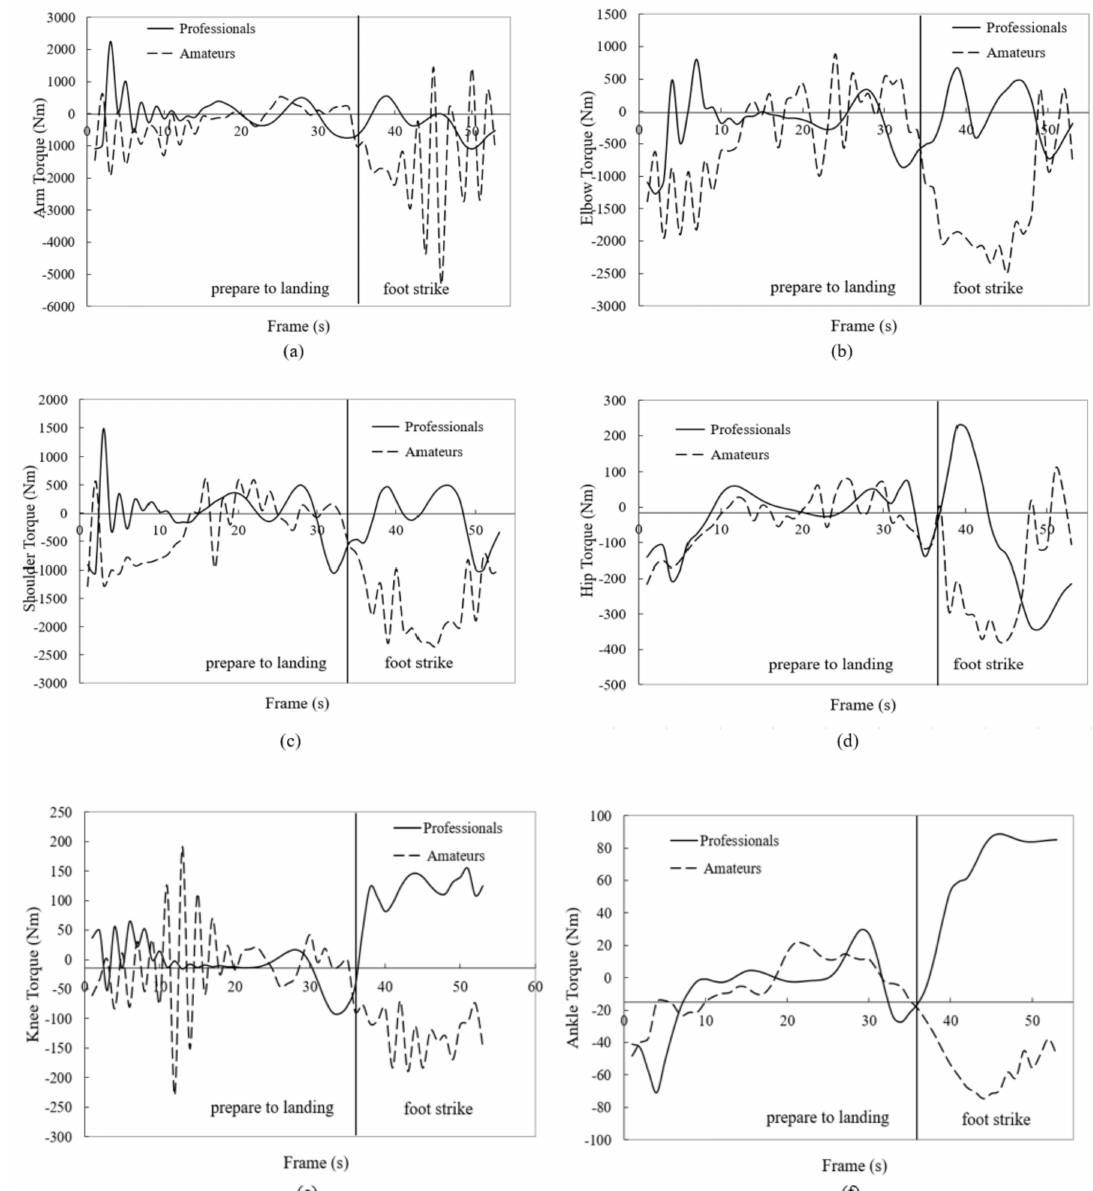
Figure 5. Graph of Torque at ( a ) arm, ( b ) elbow, ( c ) shoulder, ( d ) hip, ( e ) knee and ( f ) ankle. Table 3 shows the data collection is then validated with the numerical method technique by employing the Runge-Kutta analysis. The value of angle at knee joint θ 5 (rad) from professional parachutist data has been chosen to identify the percentage error. The error value percentage is calculated, and we found that the experimental data are acceptable and reliable to be used in this study since the percentage error are relatively